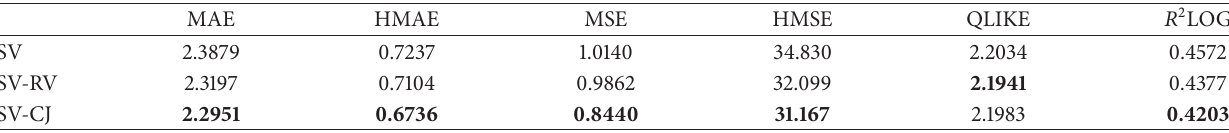
Table 3: The loss functions of in-sample forecasts.